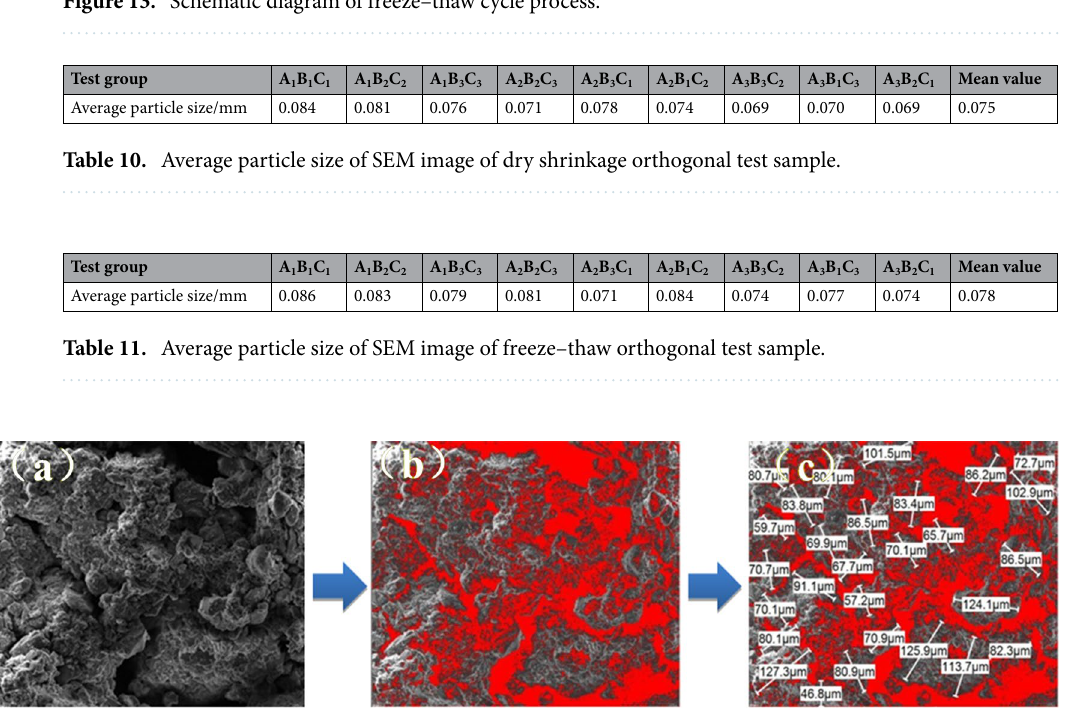
Figure 14. Image processing flow. ( a ) SEM image. ( b ) IPP software processing results. ( c ) Smileview software processing